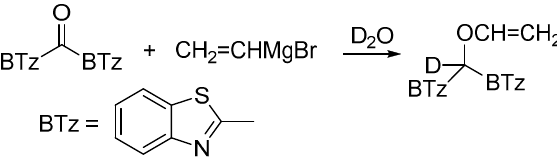
Table 2. Reactions of 1 with 2a and 2c under different experimental conditions.